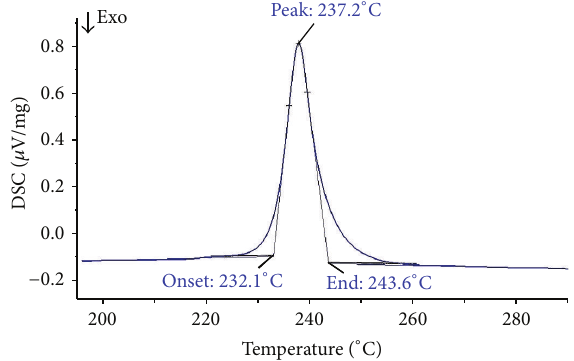
Figure 11: DSC analysis of Sn2La solder.